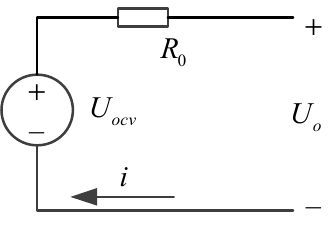
Figure 4. Simplified model of the battery pack.